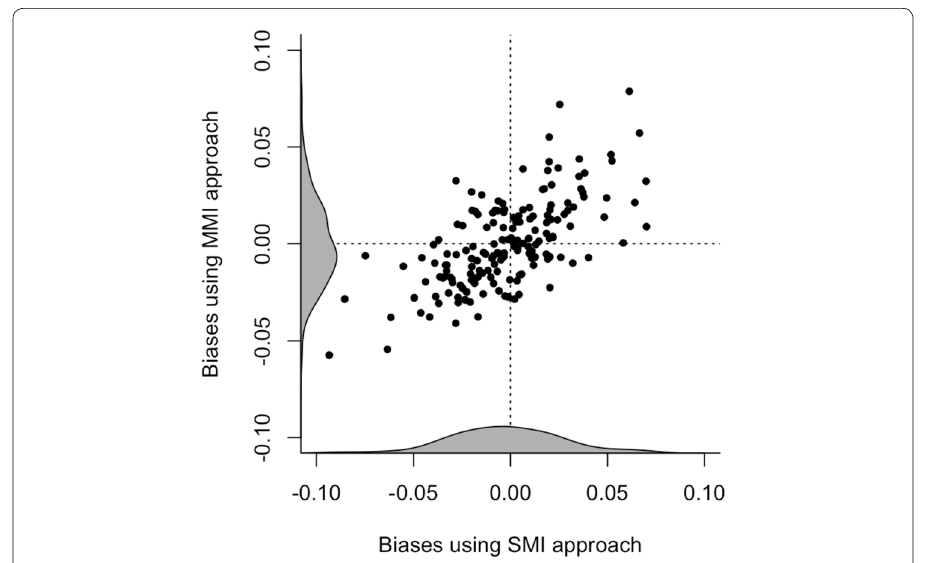
Fig. 4 PBIB design: correlation bias among the rotation